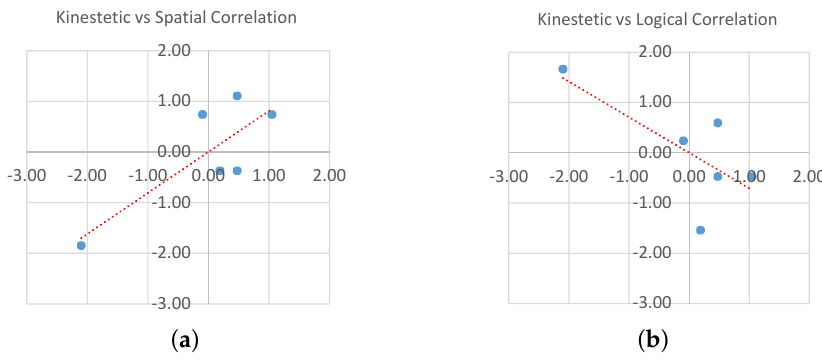
Figure 2. Scatter diagram for two pairs of dimensions: ( a ) Spatial-Visual vs. Bodily-Kinesthetic positive correlation; and ( b ) Spatial-Visual vs. Logical-Mathematical negative correlation.